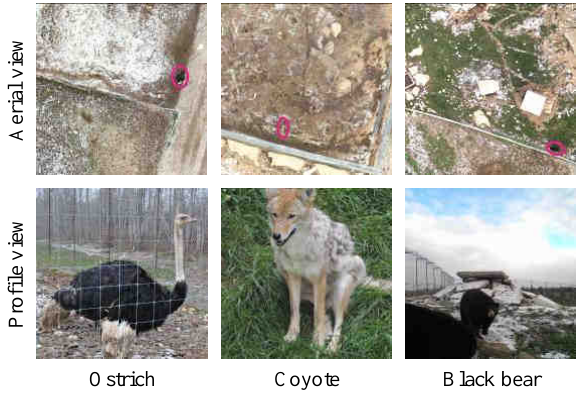
Figure 6. Other species present (magenta). Left . ostrich ( Struthio camelus ); Center . coyote ( Canis latrans ); and Right . Black bear ( Ursus americanus ). © L.-P. Chrétien, CGQ